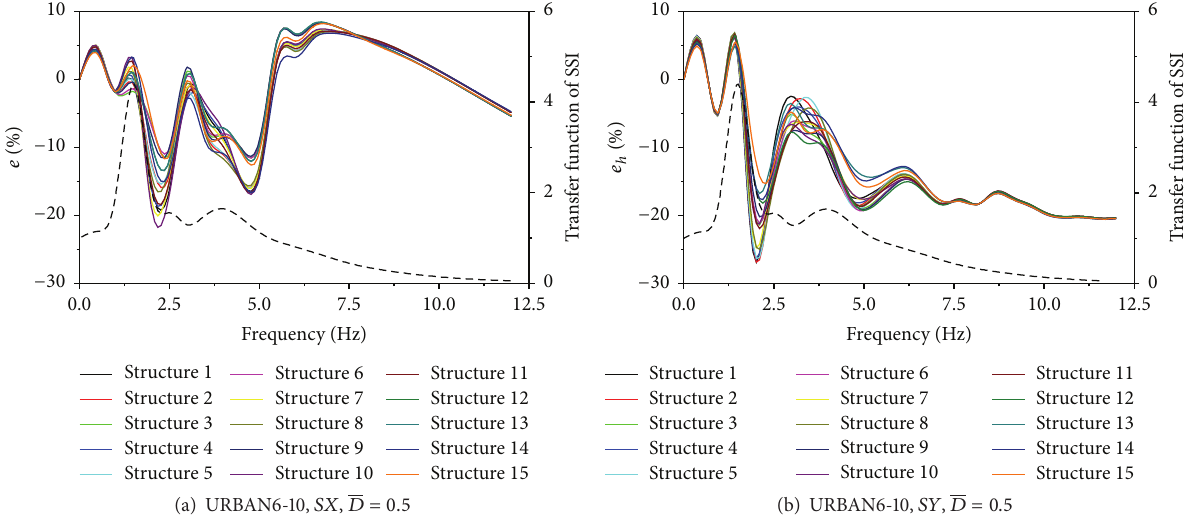
Figure 25: Interaction among structures in terms of influence coefficient 𝑒 ℎ . The solid lines are the influence coefficient 𝑒 ℎ of URBAN6-10 system. The dashed line is the transfer function 𝑄 in the URBAN1-1 (SSI)